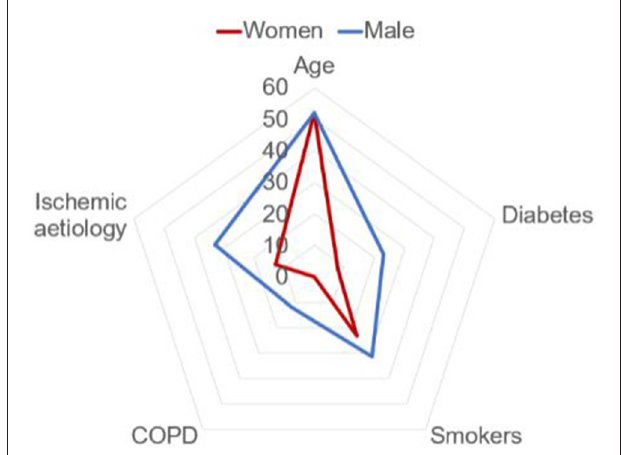
FIGURE 1 | Baseline characteristics according to